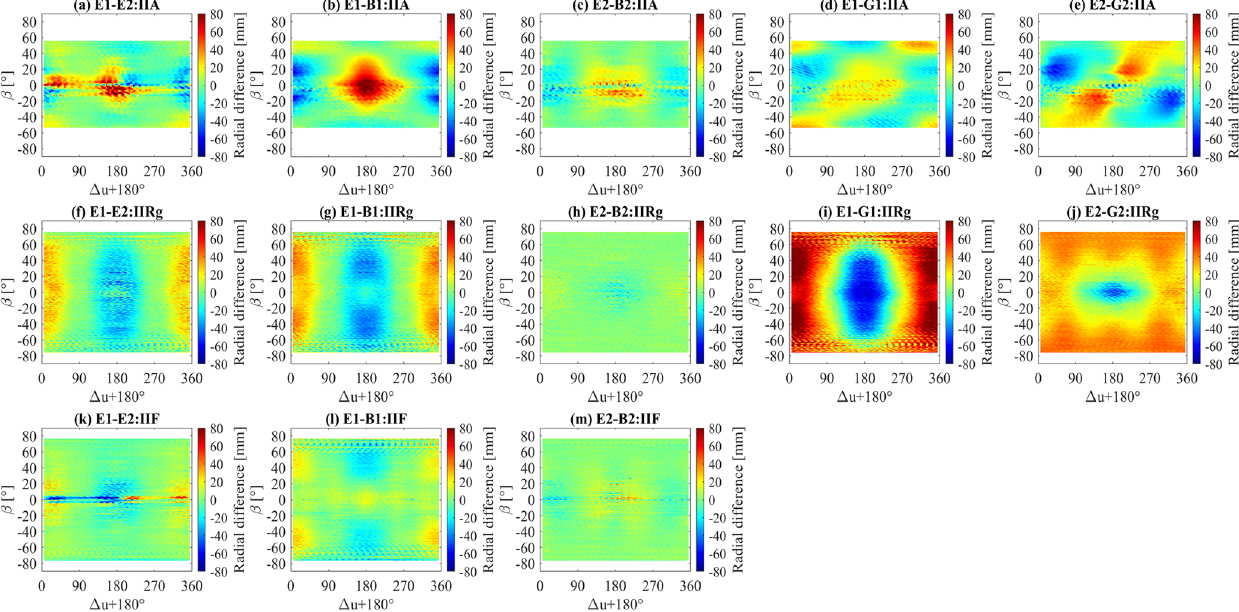
Figure 2. Orbit differences of E1–E2, E1–B1, E2–B2, E1–G1, E2–G2 (from left to right) in radial direction for Block IIA (upper), Block IIR/IIR-M (middle), Block IIF